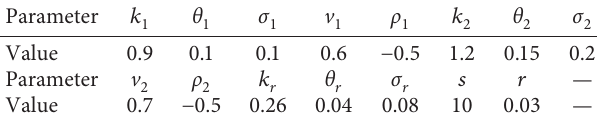
Table 1: Parameter values for the numerical analyses. Parameter